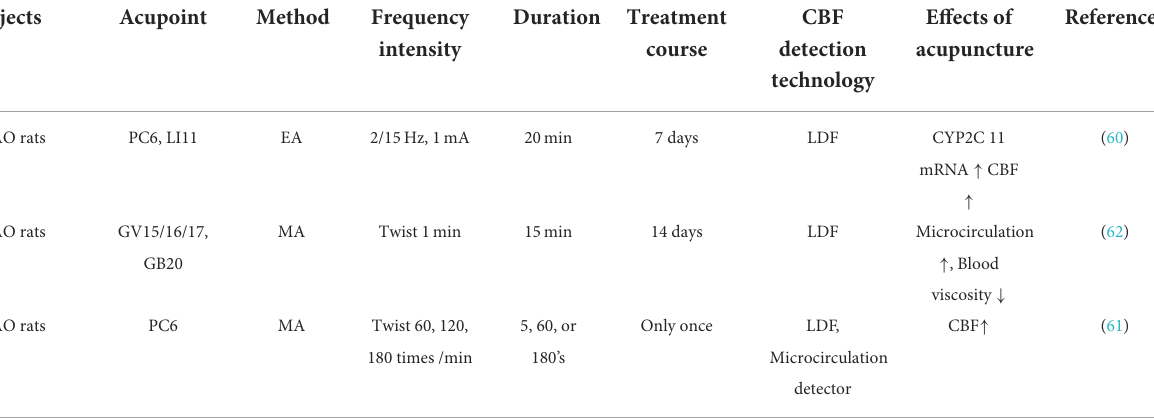
TABLE 4 Acupuncture modulates